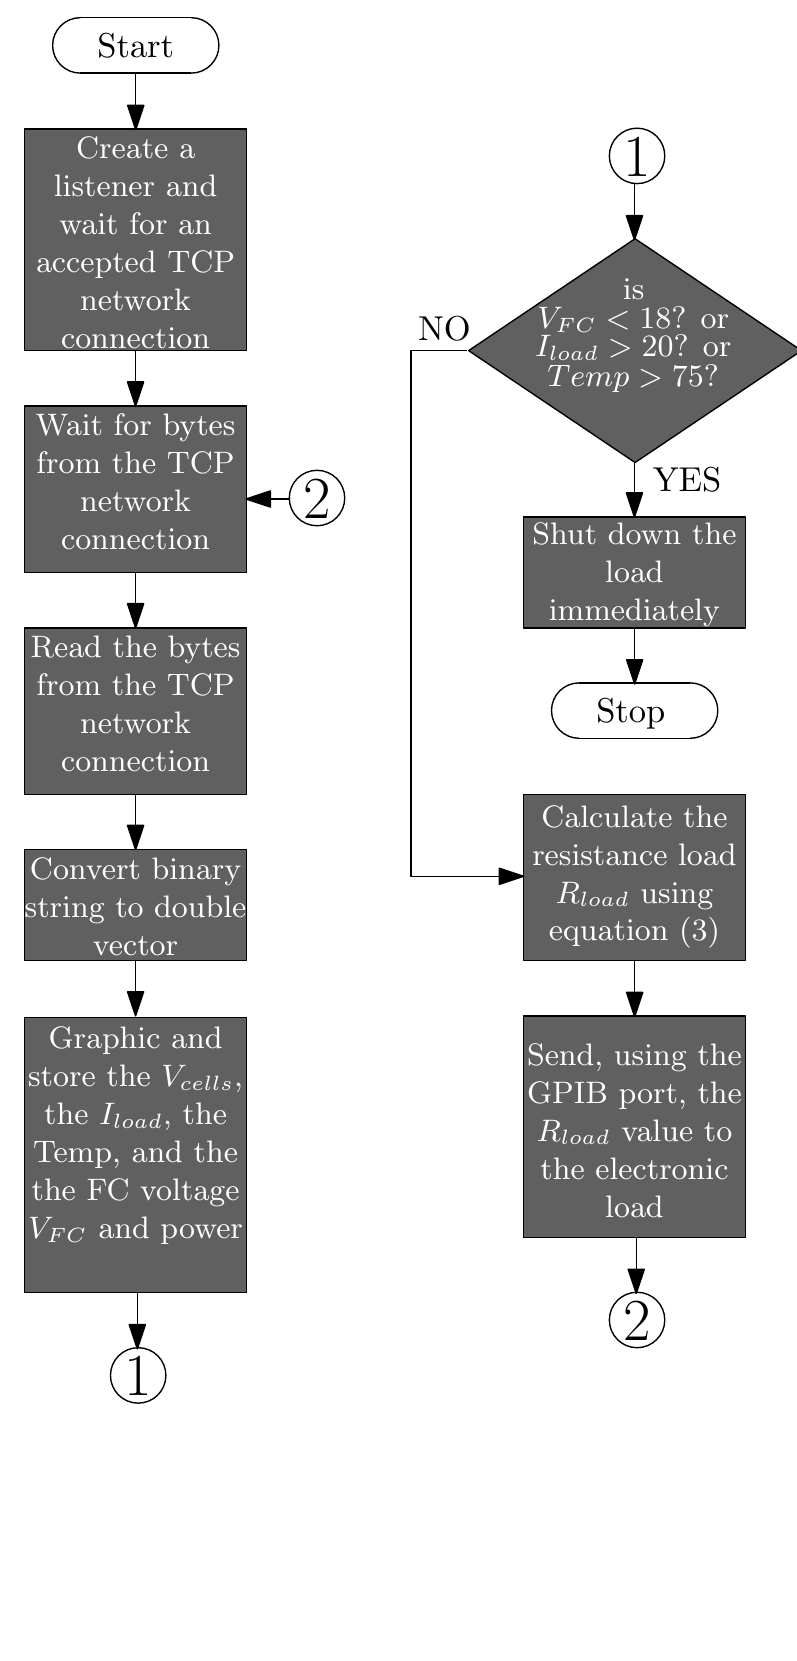
Figure 9. Host program flowchart